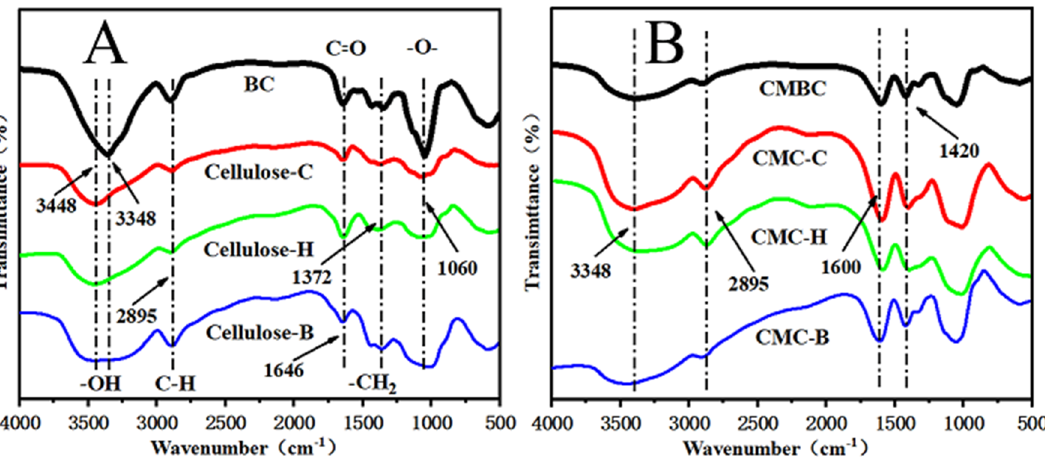
Figure 3. FTIR spectrum of ( A ) BC, cellulose ‐ C, cellulose ‐ H, cellulose ‐ B, ( B ) CMBC, CMC ‐ C, CMC ‐ H, and CMC ‐ B.